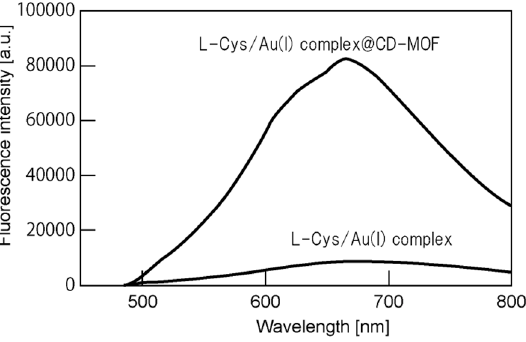
Figure 7. Emission spectra of the L-Cys/Au(I) complex and L-Cys/Au(I)@CD-MOF with the same concentration of L-Cys/Au(I).